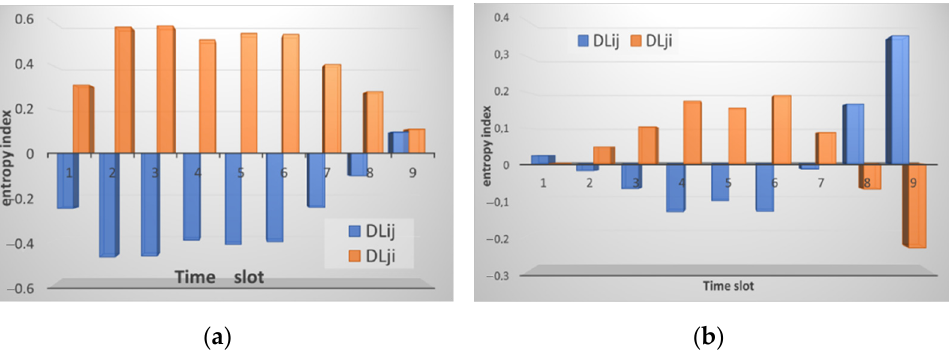
Figure 3. The result of calculating the entropy for: ( a ) received packets and ( b ) sent packets by node i relative to node j (marked in blue) and node j relative to node i (marked in orange).